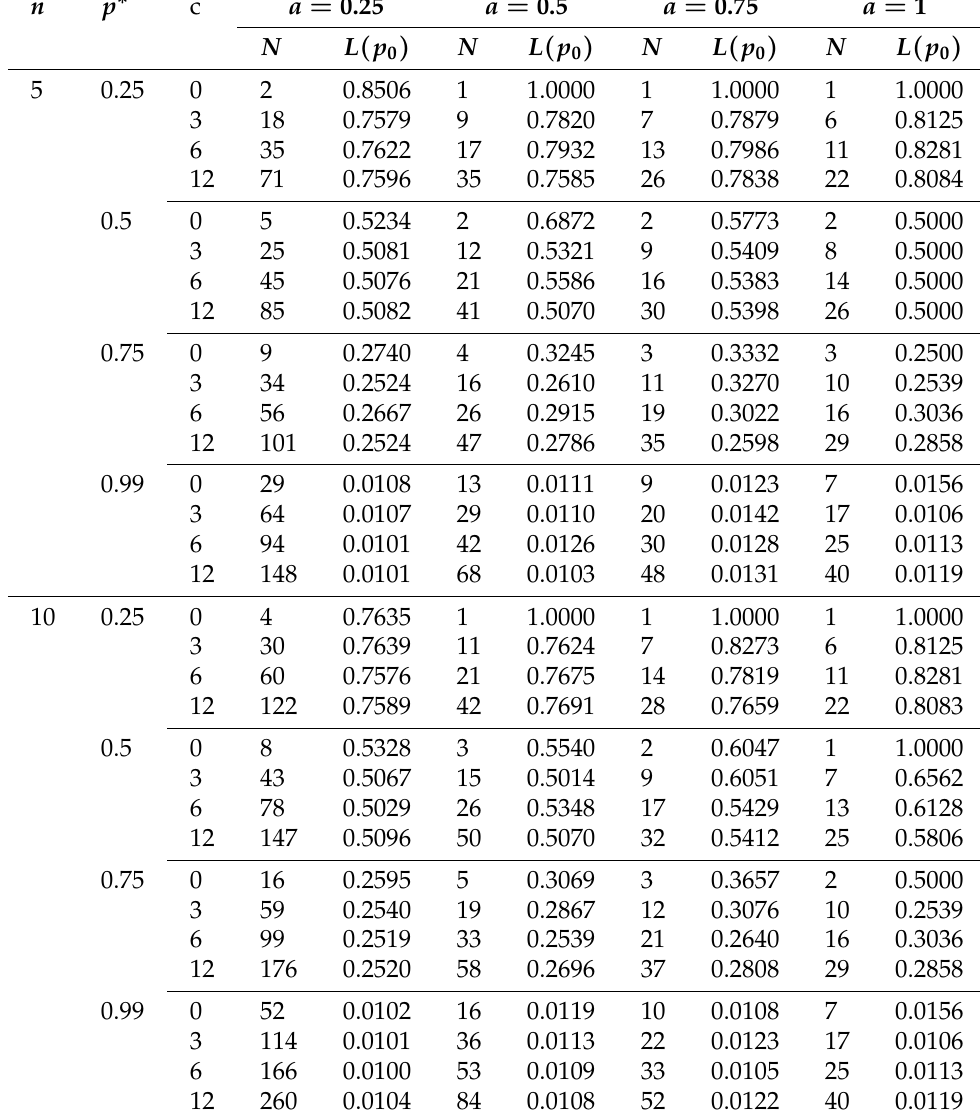
Table 5. Numerical outcomes of a single sampling plan for FB model at combination